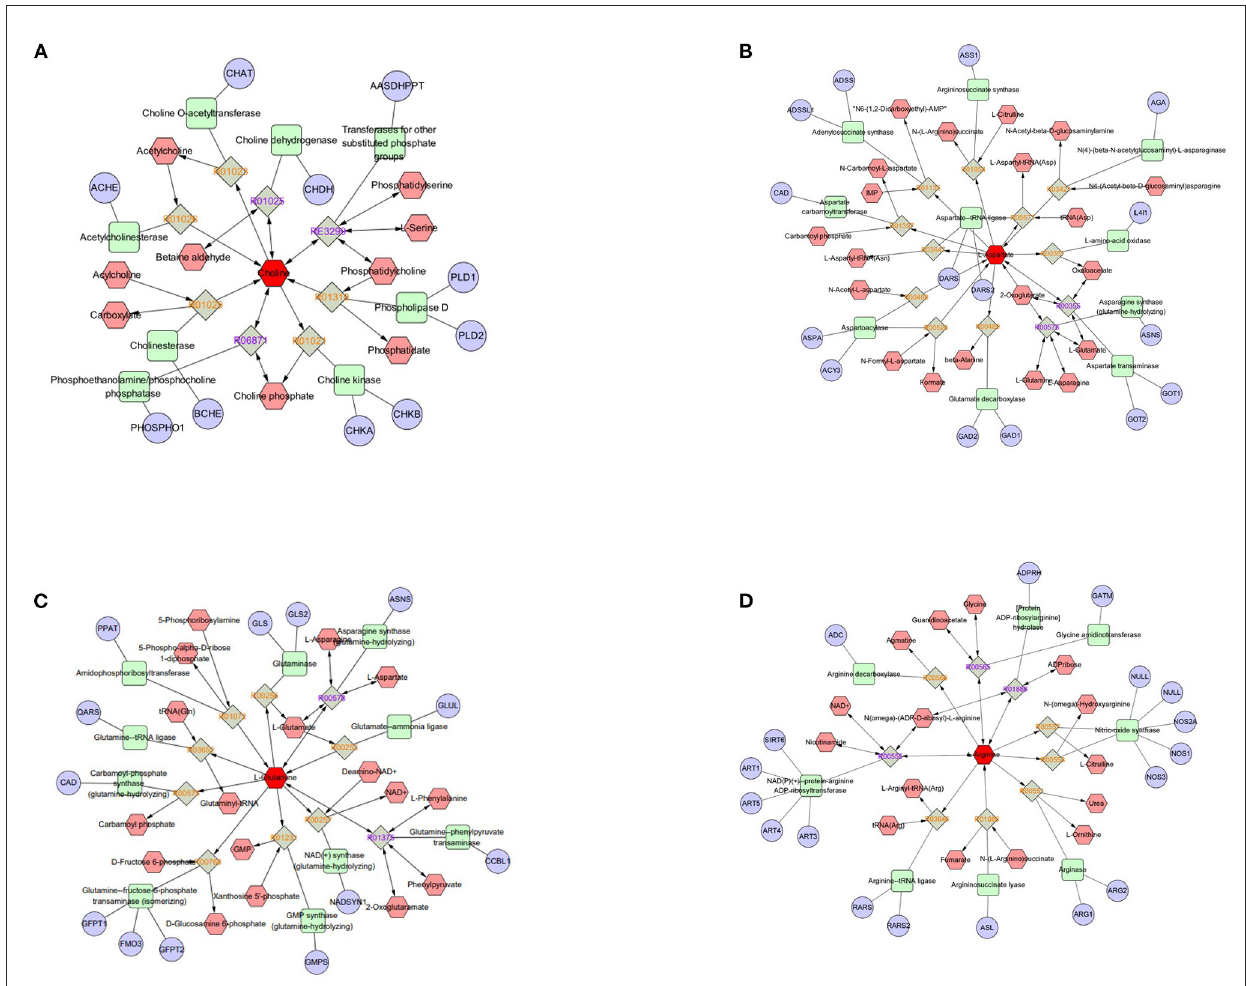
FIGURE6 Compound-reaction-enzyme-gene networks of important differential metabolite biomarkers de-termined using Metscape. (A) Choline, (B) L-aspartate, (C) L-glutamine, and (D) L-arginine. The metabolites are shown in red hexagons. Gray squares: reaction nodes with reaction ID; pale red hexagons: compound nodes; green squares: enzyme nodes; blue circles: gene nodes.